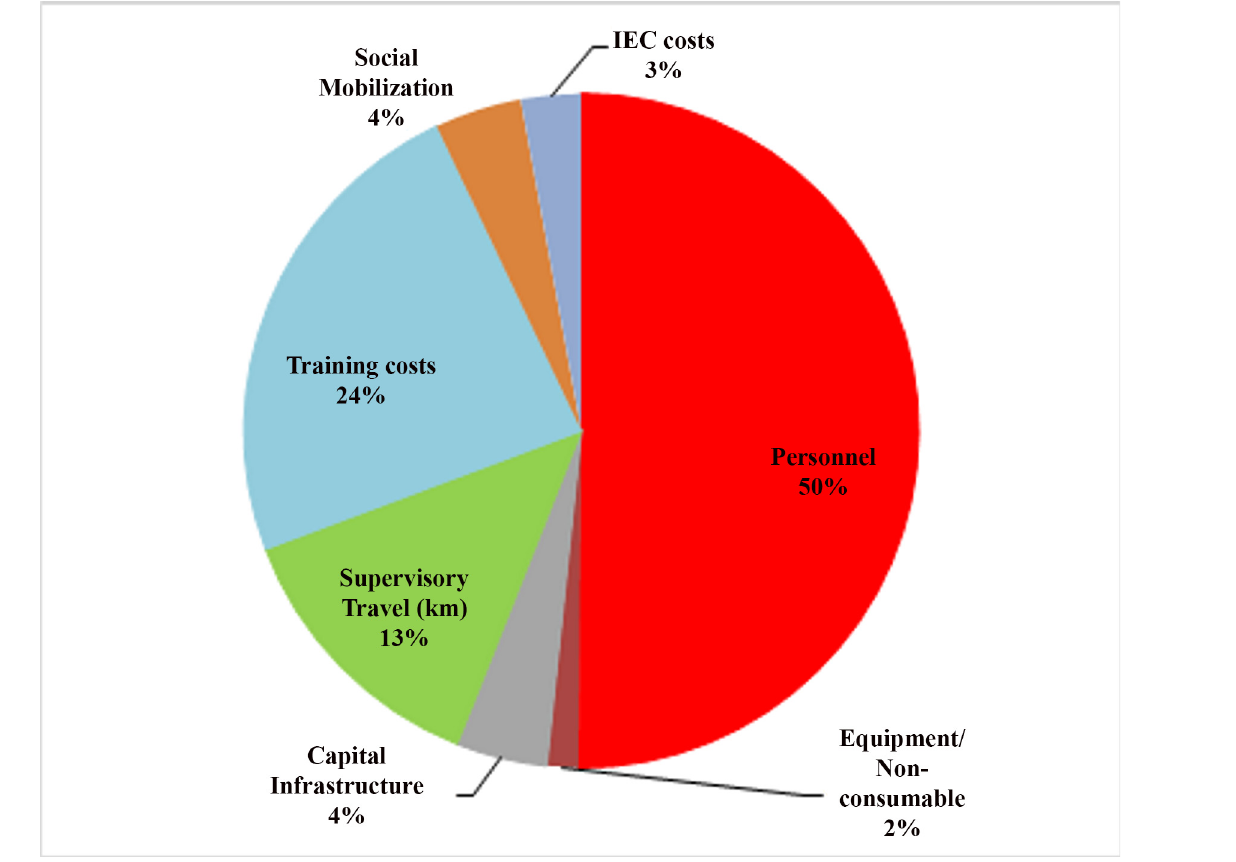
Fig 4. Distribution of incremental program implementation and monitoring costs as a result of